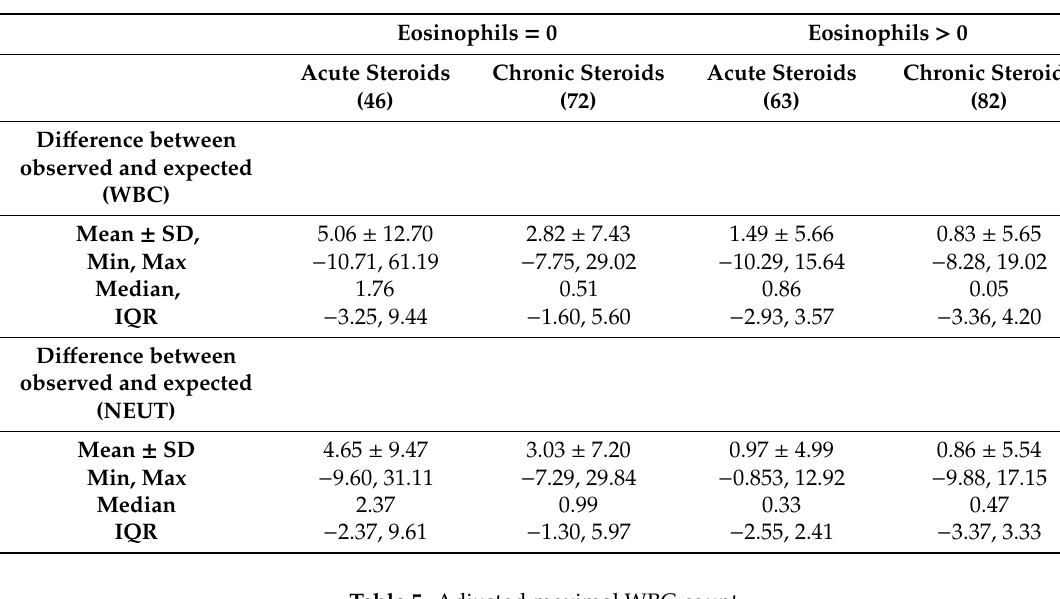
Table 5. Adjusted maximal WBC